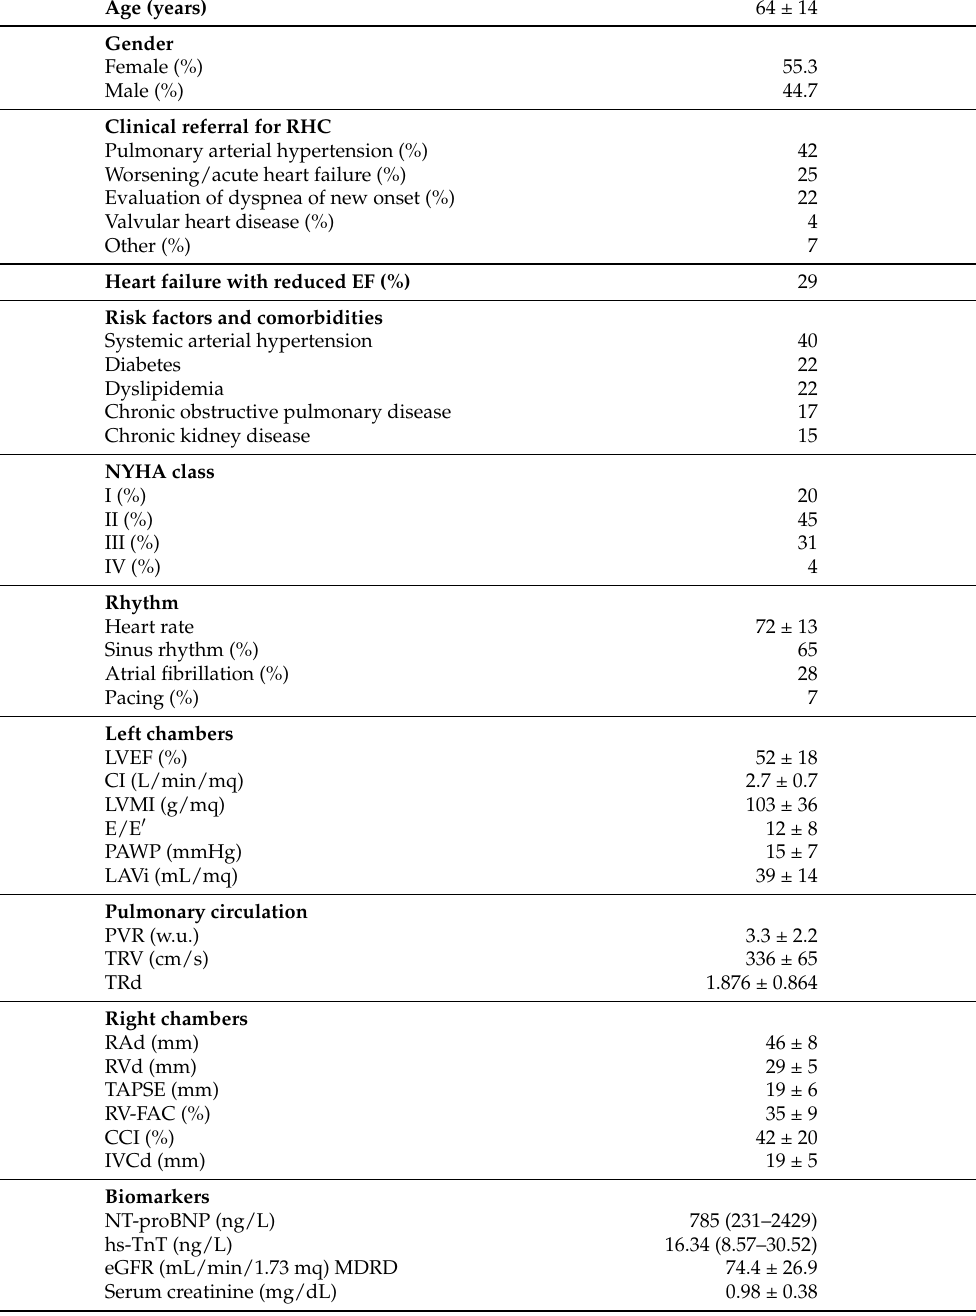
Table 2. Characteristics of the population included in our dataset. CI: cardiac index; CCI: cardiac caval index; eGFR: estimate glomerular filtration rate (mdrd equation); hs-TnT: high sensitivity troponin T; IVCd: inferior vena cava diameter; LAVI: left atria volume index; LVEF: left ventricular ejection fraction; LVMI: left ventricular mass index; NYHA: New York Heart Association; NT- proBNP: amino terminal pro brain natriuretic peptide; PAWP: precapillary artery wedge pressure; PVR: pulmonary vascular resistances; RAd: right atrial diameter; RVd: right ventricular diameter; RV-FAC: right ventricular fractional area change; TAPSE: tricuspid annular plane excursion; TVR: tricuspid regurgitation velocity; TRd: tricuspid regurgitation degree. Age (years) 64 ± 14 Gender Female (%) 55.3 Male (%) 44.7 Clinical referral for RHC Pulmonary arterial hypertension (%) 42 Worsening/acute heart failure (%) 25 Evaluation of dyspnea of new onset (%) 22 Valvular heart disease (%) 4 Other (%) 7 Heart failure with reduced EF (%) 29 Risk factors and comorbidities Systemic arterial hypertension